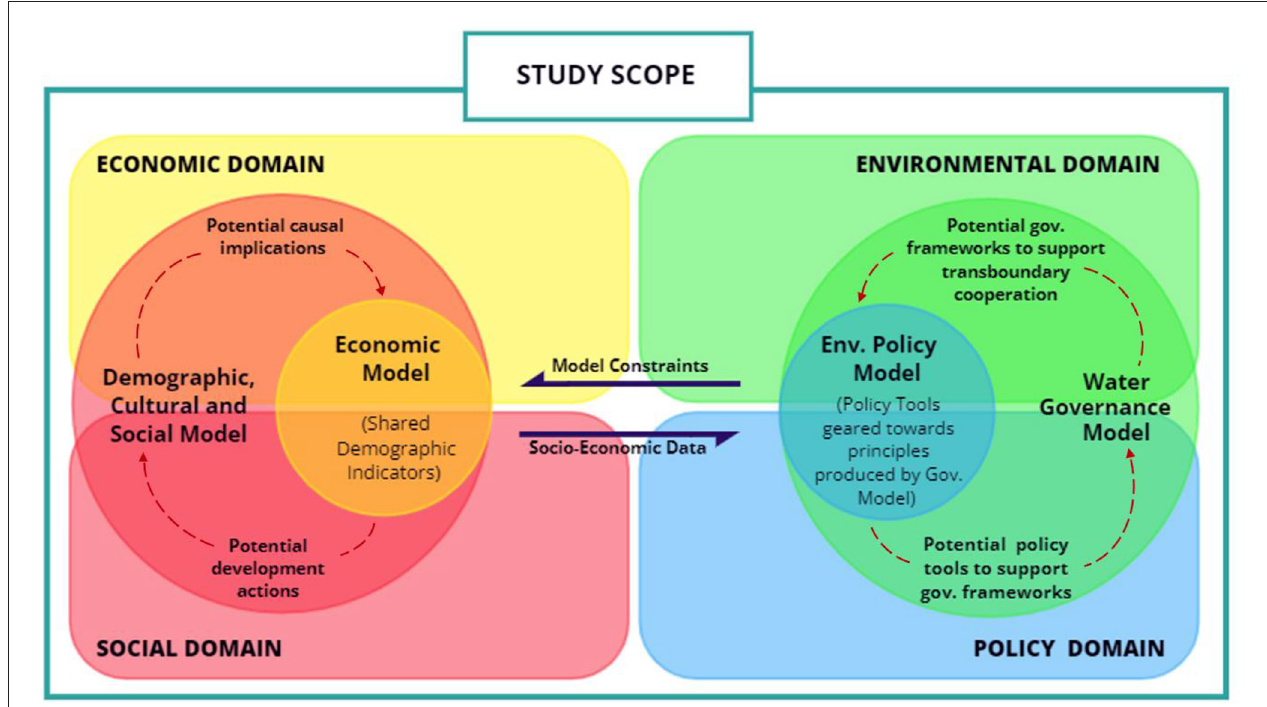
FIGURE 2 | Map of interconnected relationships between the individual models under sustainable development